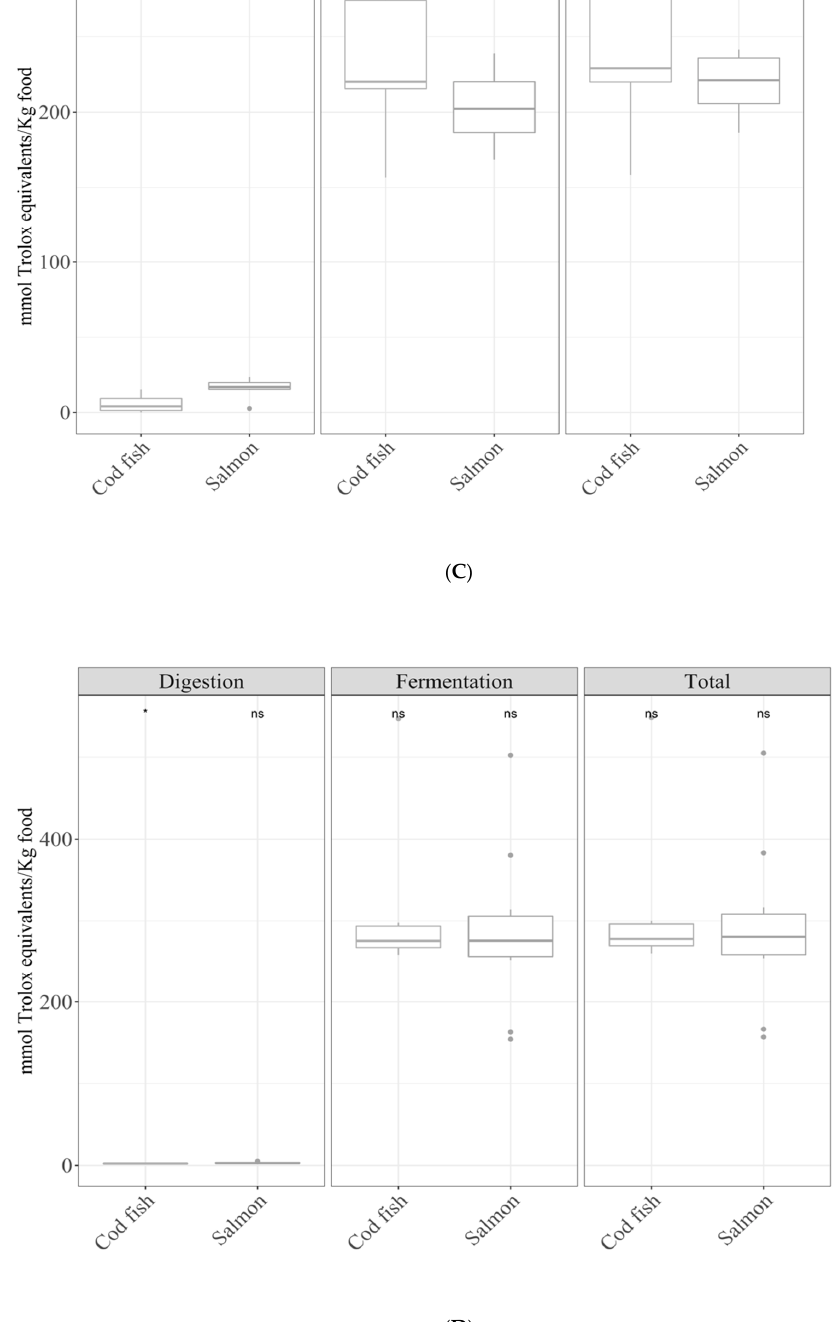
Figure 5. Antioxidant capacity of digested-fermented fish (cod fish and salmon) depending on the cooking technique (( A ) TEAC DPPH , ( B ) TEAC FRAP ) and depending on the sample (( C ) TEAC DPPH , ( D ) TEAC FRAP ). Statistical analysis was performed through ANOVA using raw vegetables or mean of all food groups as the reference group. Statistic labels: *: p < 0.05, **: p < 0.01, ***: p < 0.001, ****: p < 0.0001, ns: not significant. On the other hand, by sample (Table S7), in the case of TEAC DPPH (Figure 5C), when comparing the means of the different samples (ANOVA paired comparisons, p < 0.05), salmon (blue fish) was more antioxidant than cod fish (white fish) after digestion; for